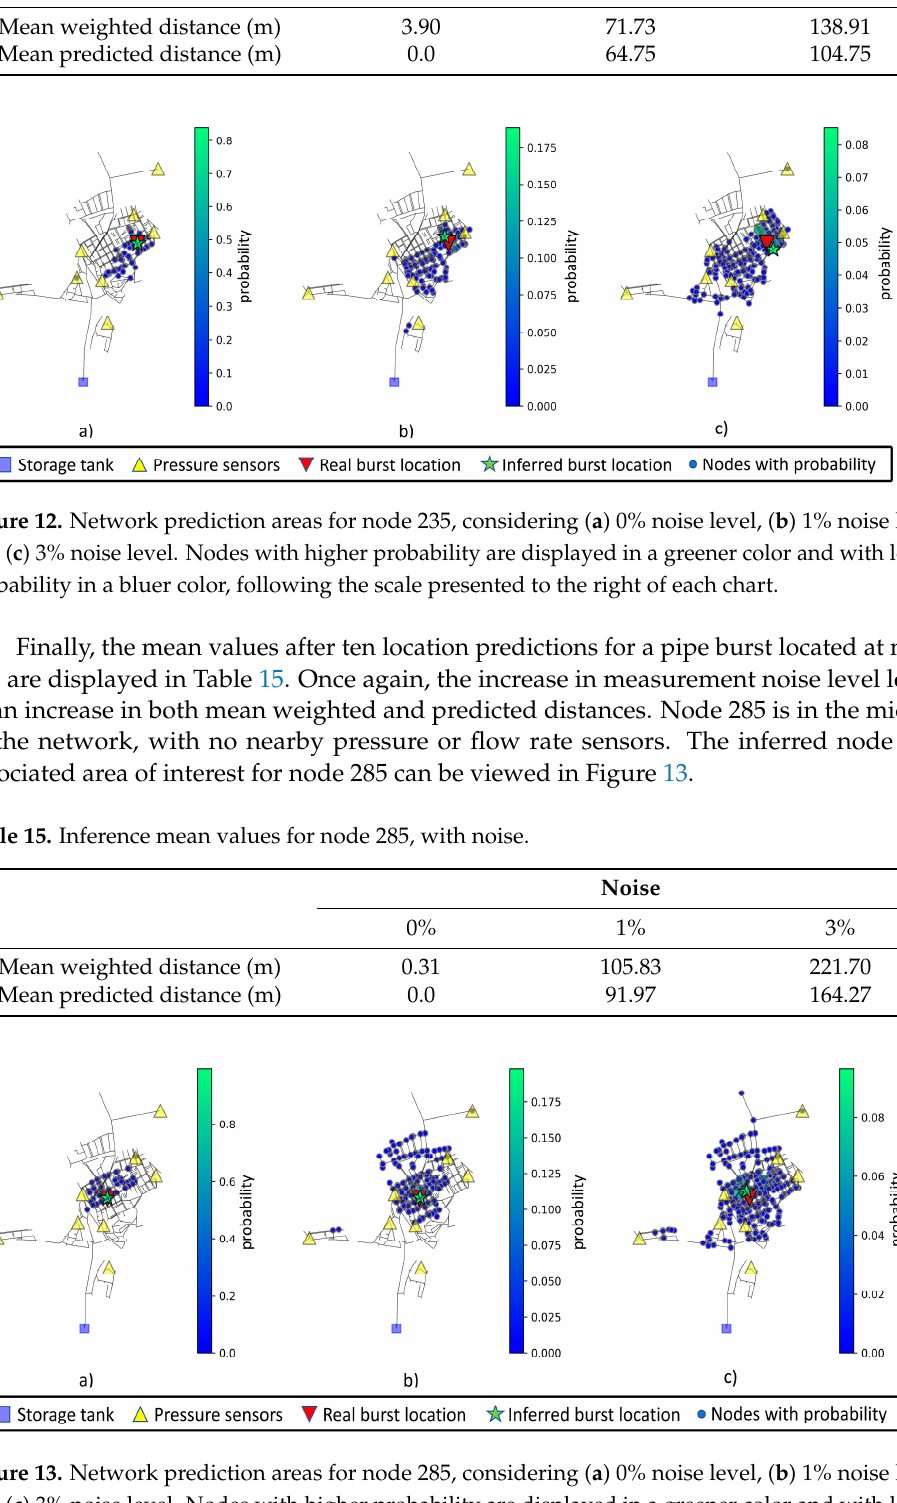
Table 14. Inference mean values for node 235, with noise.